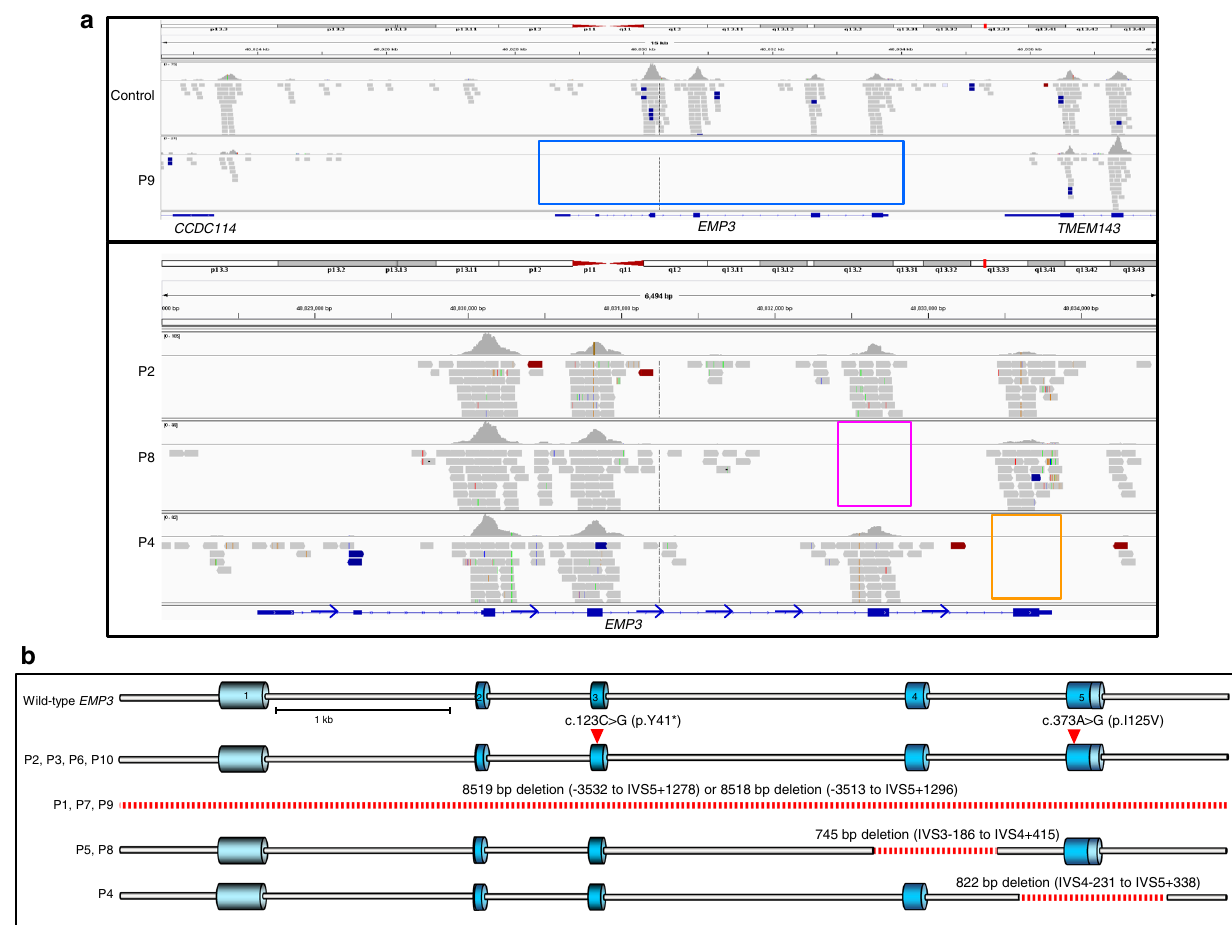
Fig. 1 DNA sequencing of ten unrelated MAM-negative individuals revealed inactivating mutations in EMP3 . a Exome sequence alignments over the EMP3 gene region demonstrate four inactivating mutations in fi ve MAM-negative individuals. EMP3 was the only candidate gene that passed our fi ltering strategy with predicted loss of function mutations found in all tested MAM-negative samples. Upper panel (chr19; 48,822,471 to 48,837,471) shows a complete deletion of EMP3 in P9 (blue box) revealed by a lack of coverage over any targeted exons as compared to control, although fl anking genes CCDC114 and TMEM143 show sequencing coverage. Lower panel (chr19; 48,828,000 to 48,834,500) shows homozygous nonsense mutation (c.123C> G; p.Tyr41Ter) in P2 (brown line); deletion of EMP3 exon 4 in P8 (pink box) and P5 (data not shown); deletion of EMP3 exon 5 in P4 (orange box). b Sanger sequencing was used to con fi rm these mutations and identify EMP3 mutations in a further fi ve MAM-negative individuals and deletion breakpoints were identi fi ed where appropriate (summarised in Supplementary Table 5). EMP3 inactivating mutations in all patients (P1 – P10) are depicted on the gene schematic, with dark blue areas depicting coding exons, light blue areas UTRs and deleted regions depicted by dashed red